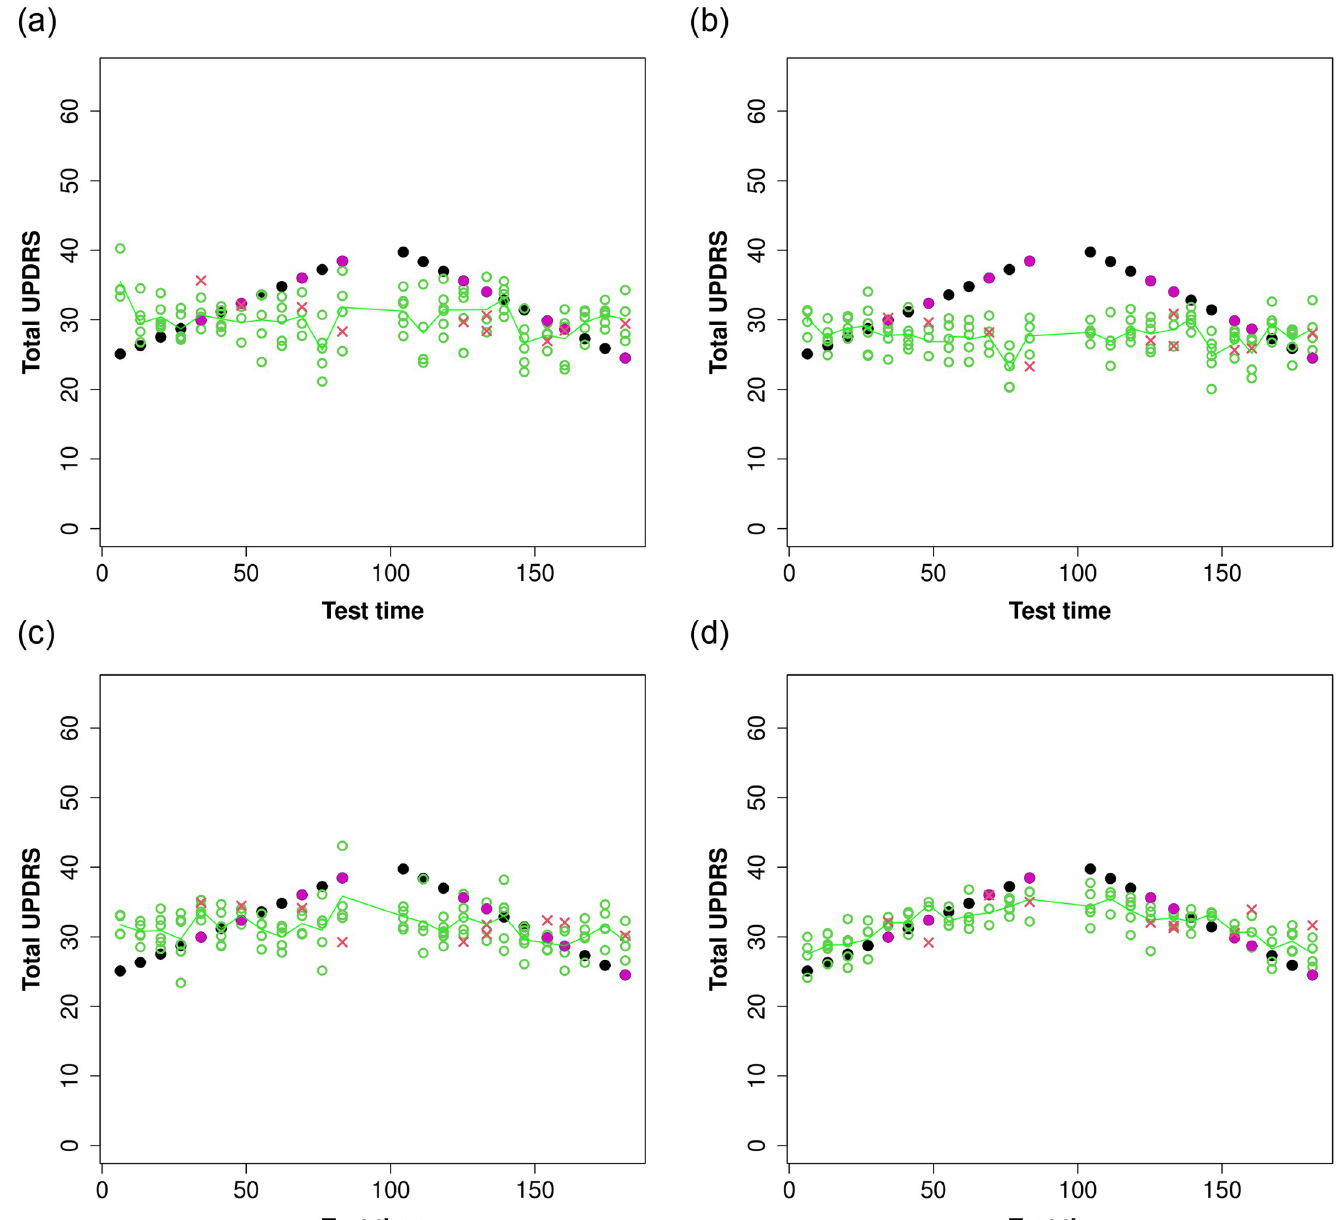
Fig 3. Patient fitting example: Black points are actual UPDRS values, whereas green points are the fitted values plus a smoothing (green line). Points in magenta represent selected test points with red crosses as their prediction. (a) Radial basis kernel, (b) Sum of kernels, (c) Product of kernels and (d) Product of kernels grouping by